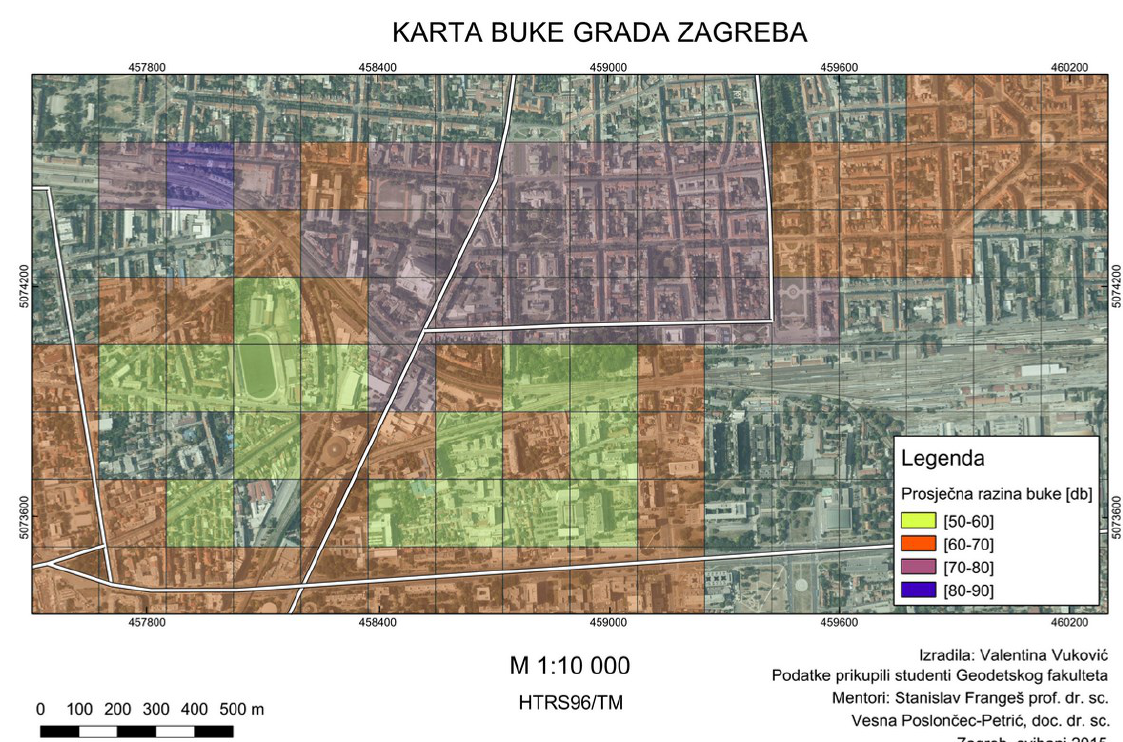
Figure 10. Scaled Noise map of the city of Zagreb created using the voluntarily measured data with the NoiseTube application (Vuković,